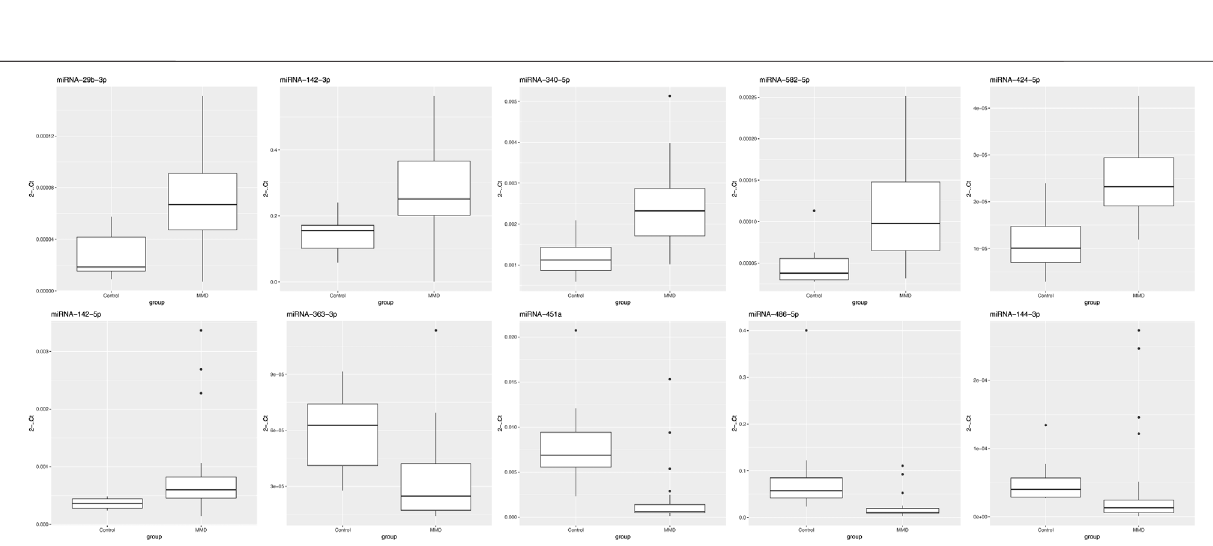
FIGURE 3 | The fold change in the microarray and RT-PCR for all the validated miRNAs. The results demonstrated good consistency between the microarray and RT-PCR.